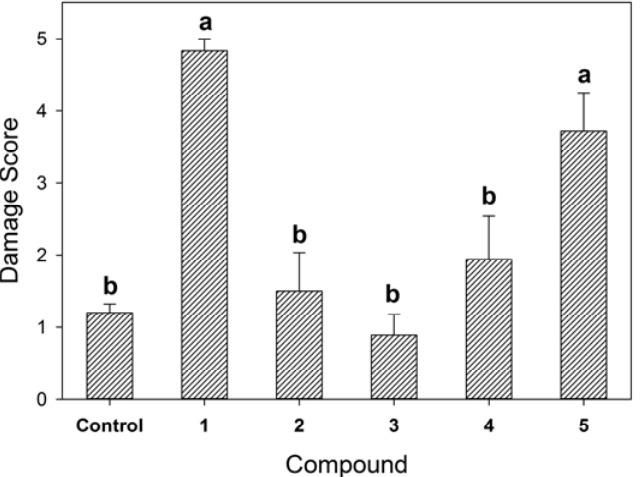
Figure 6. Effect of five pure compounds obtained from R. capillus ‐ albis solid culture on juvenile plants of B. tectorum when tested at 10 − 4 M in a juvenile plant immersion bioassay against a methanol solvent control. Symptoms were scored at 10 days on an approximately linear scale from 0 (no visible damage) to 5 (complete mortality). Bars headed by the same letter (a or b) are not significantly different at p < 0.05 according to a means separation test from analysis of variance.